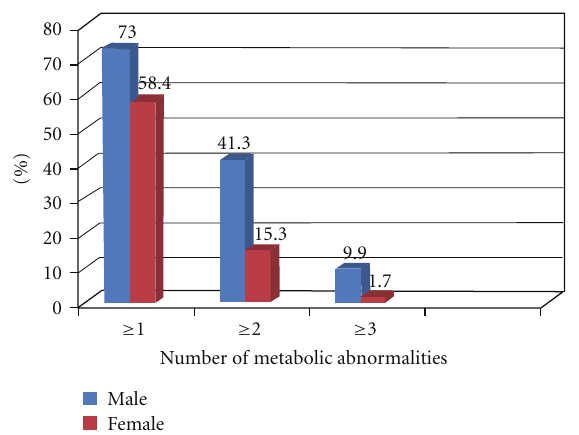
Figure 1: Prevalence of the ≥ 1, ≥ 2, and ≥ 3 metabolic abnormalities among Saudi college students by sex.